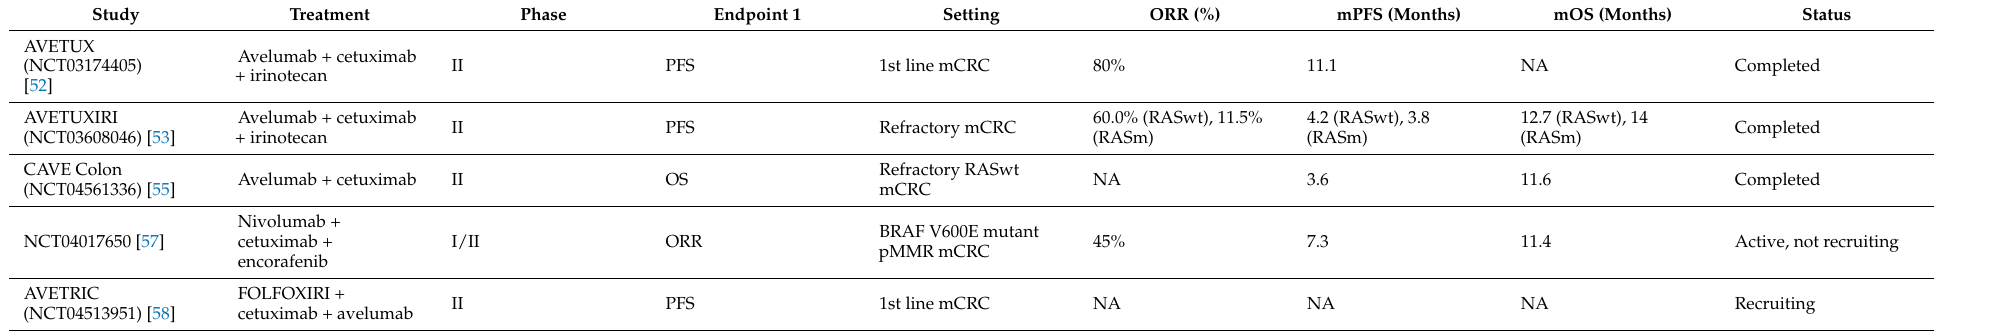
Table 3. Currently ongoing and completed clinical trials of anti-EGFR, CT, and ICIs in MSS